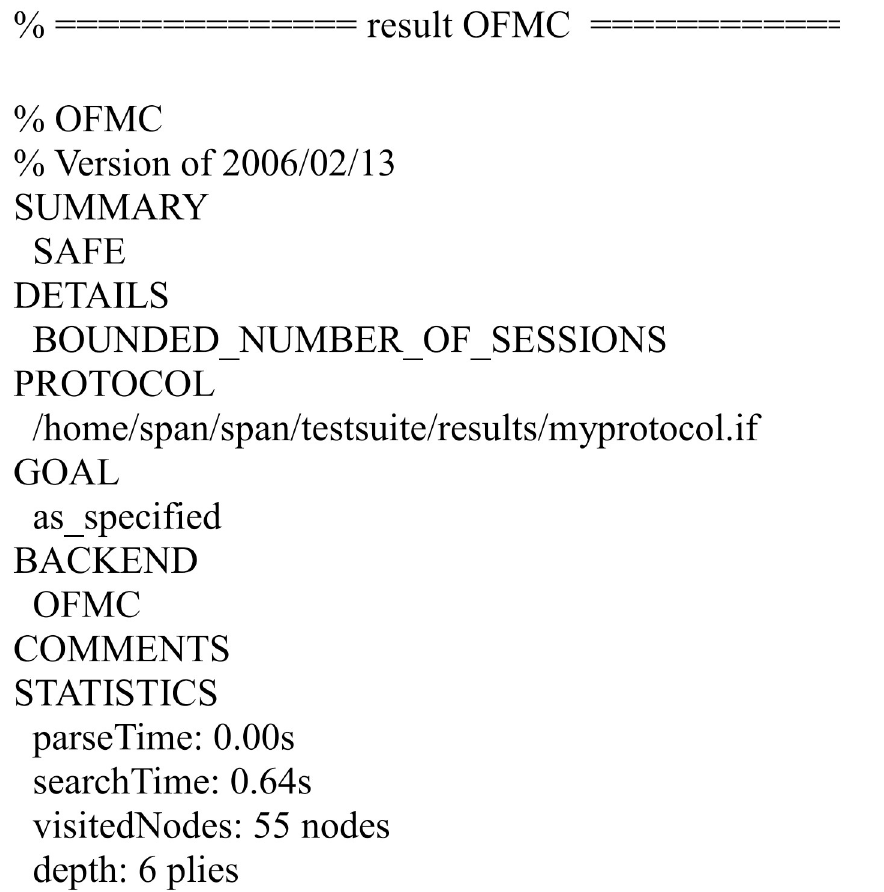
Fig 10. The result of the analysis using OFMC